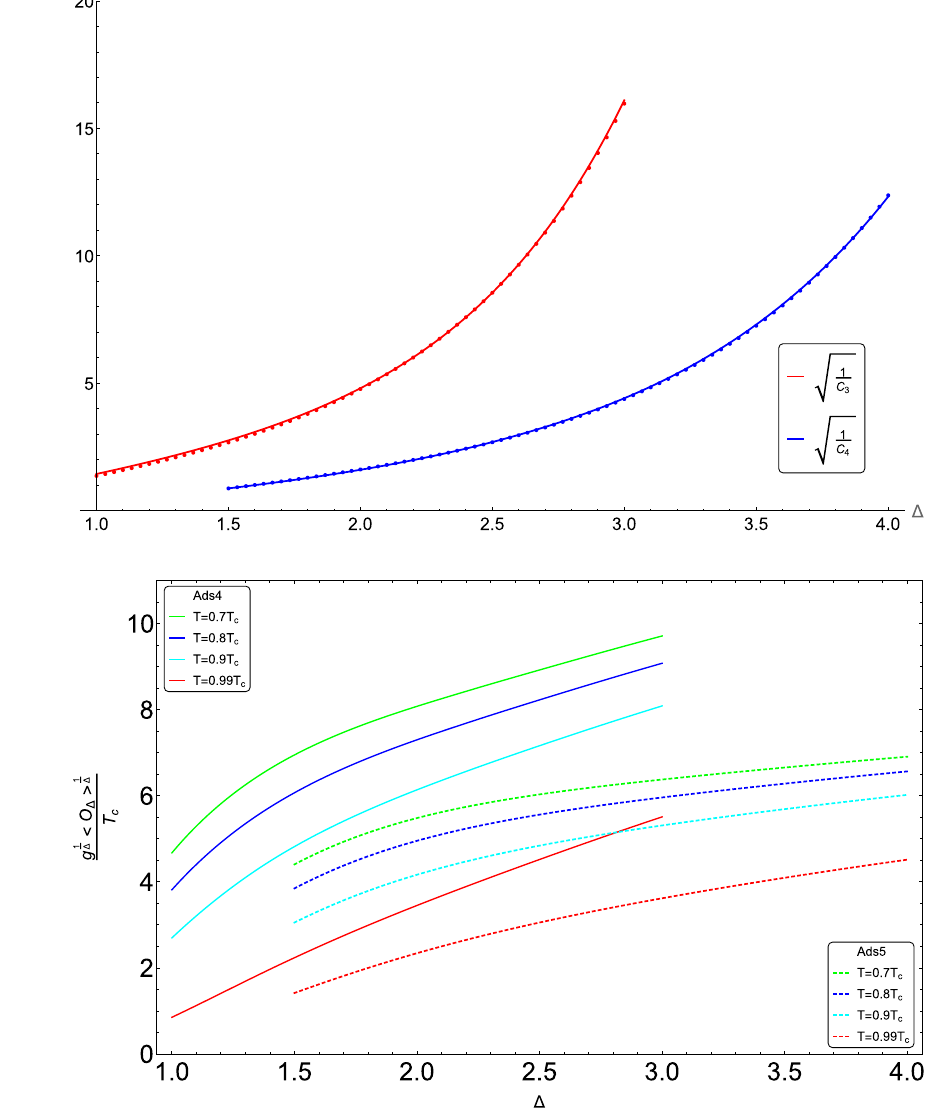
√ Fig. 4 a 1 / C 3 data by Eqs. (4.4) and (4.5) with Eq. (3.31), as functions of (cid:2) . Red colored curve is the plot of √ Eq. (4.6). b 1 / C 4 data by Eqs. (B.25) and (B.26) with Eq. (B.19), as functions of (cid:2) . Blue colored curve is the plot of Eq. (B.27)